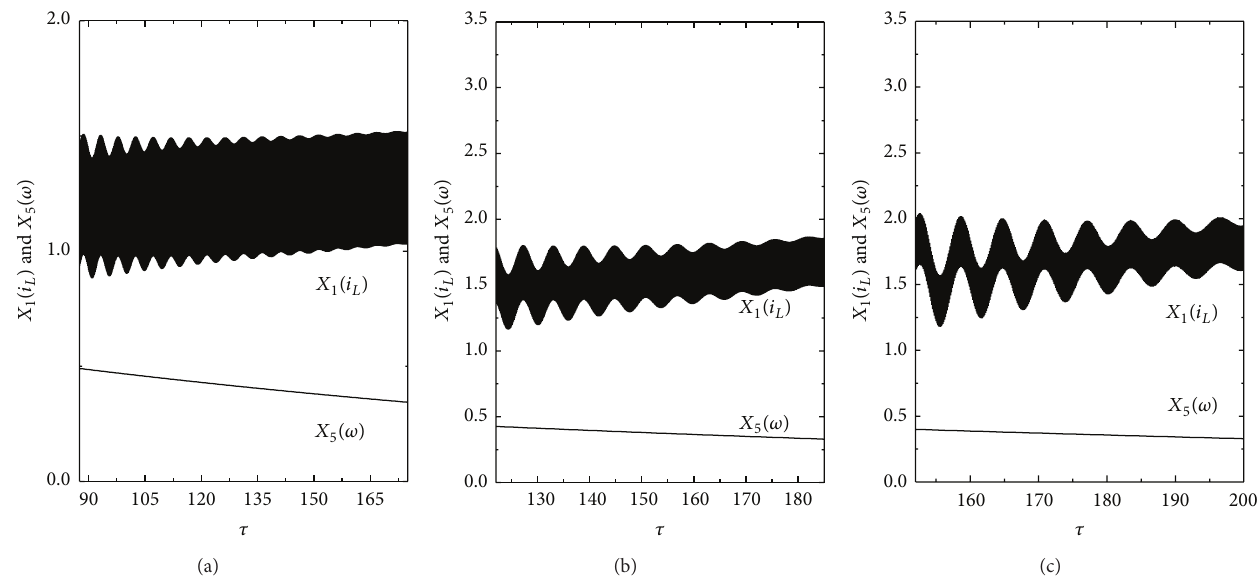
Figure 11: Time domain waveforms of QS at (a) 𝑉